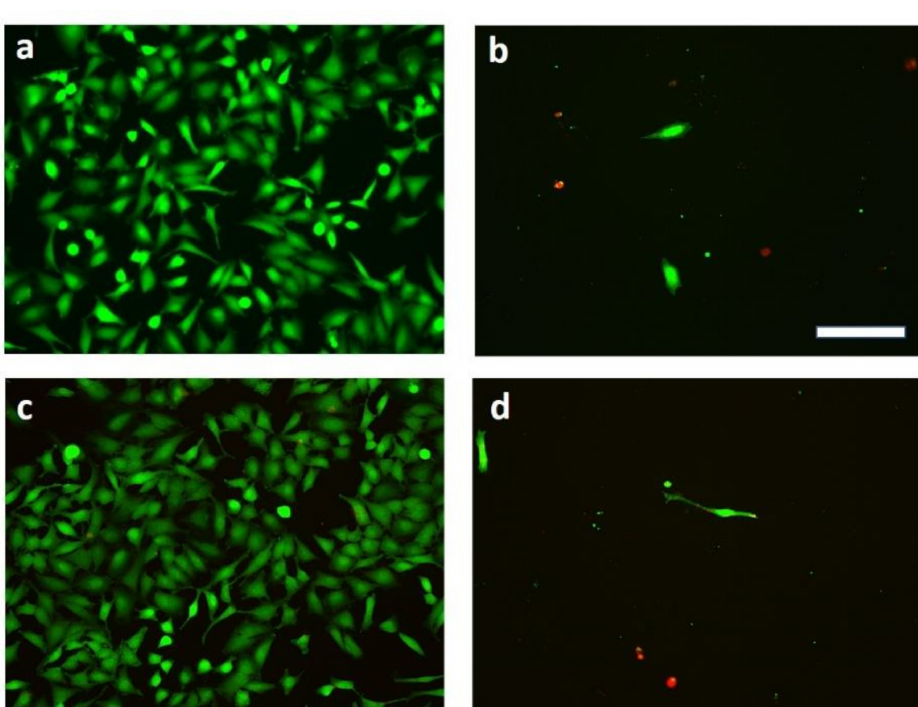
Figure 5. Representative Live/Dead staining of HeLa cells after 24 h of incubation with ( a ) D-g- PNIPAM (62.5 µ g mL − 1 ); ( b ) Dox (2.5 µ g mL − 1 ); ( c ) mock (untreated cells); ( d ) D-g-PNIPAM + Dox (62.5 + 2.5 µ g mL − 1 ). Green cells are living cells and red ones are dead. Scale bar 20 µ m (for all images).